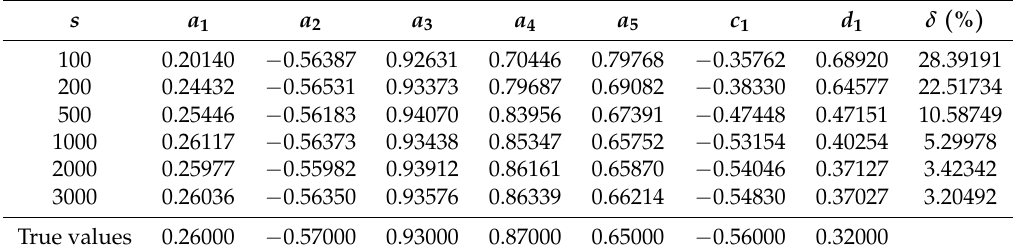
Table 2. The PC-S-RGELS estimates and their errors.